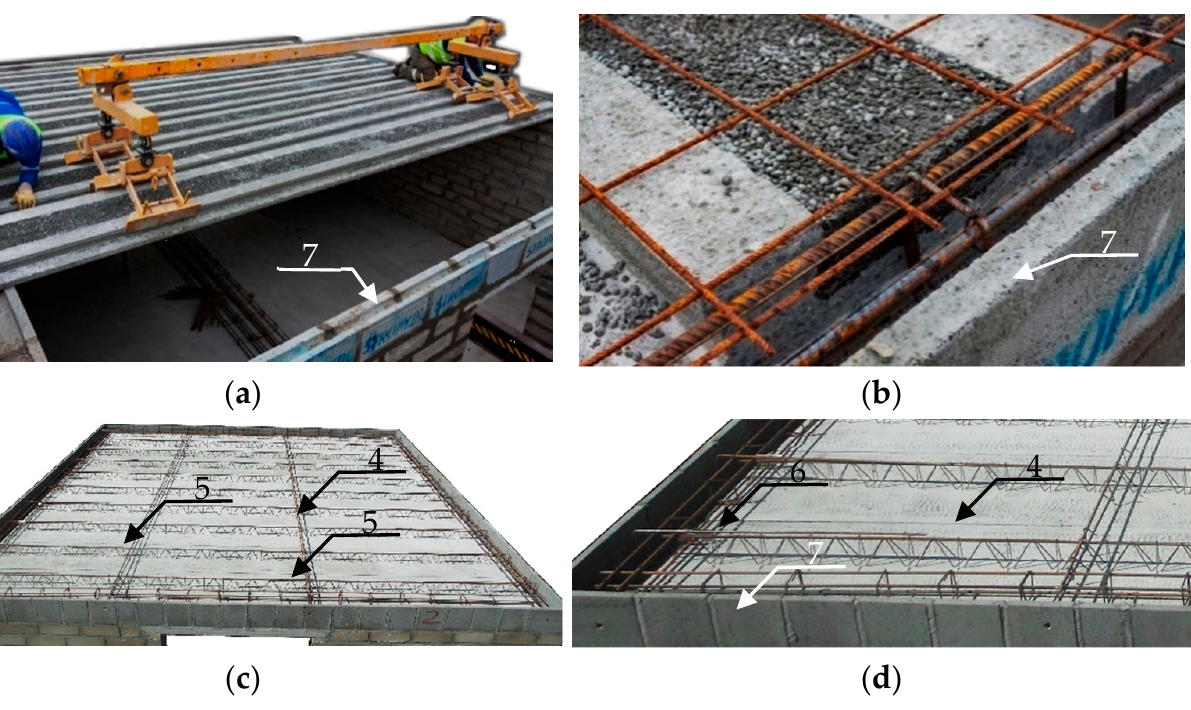
Figure 2. Research model: ( a ) ribbed panel laying; ( b ) ribbed panel support reinforcement; ( c ) lattice girder panel laying; ( d ) lattice girder panel support reinforcement. (1—wall, 2—lintel 2 × Scheme 7. 2/12/210, 3—lintel 2 × SBN 12/12/180, 4—lattice girder panel, 5—distribution ribs, 6—support reinforcement, and 7—precast bond beam form).